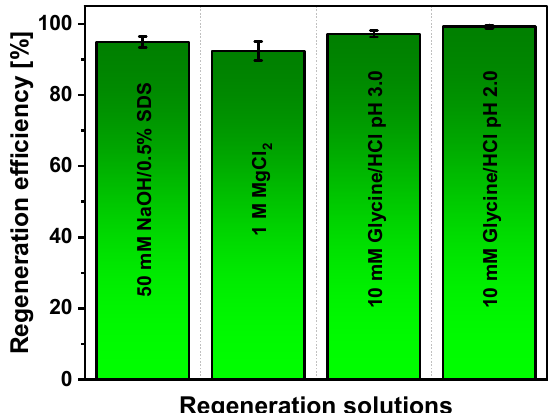
Figure 4. Dependence of Au/CD44/anti-CD44 complex dissociation and surface regeneration effi- ciency on the nature of the regeneration solution.